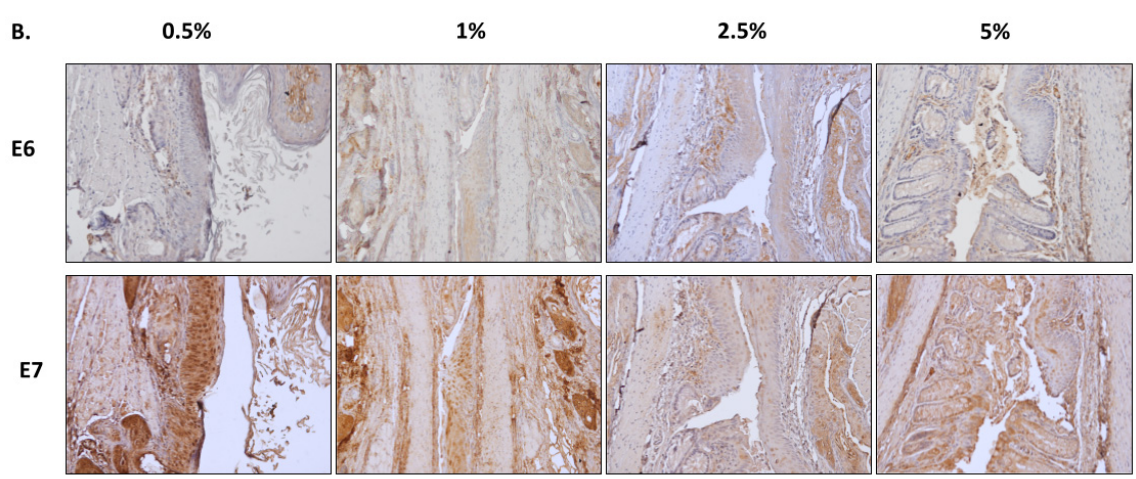
Figure 1. E6/E7 oncoprotein expression (optical density (O.D.)) in mice treated with SQV at doses, 5%, 2.5%, 1%, and 0.5% to establish a standard dosing concentration. ( A ) Mean E6 and E7 expression quantified from N = 4 mice per SQV dosage group, each distribution male and female; ( B ) Representative images of anal tissue from the assigned dosages immunohistochemically stained for E6 and E7.